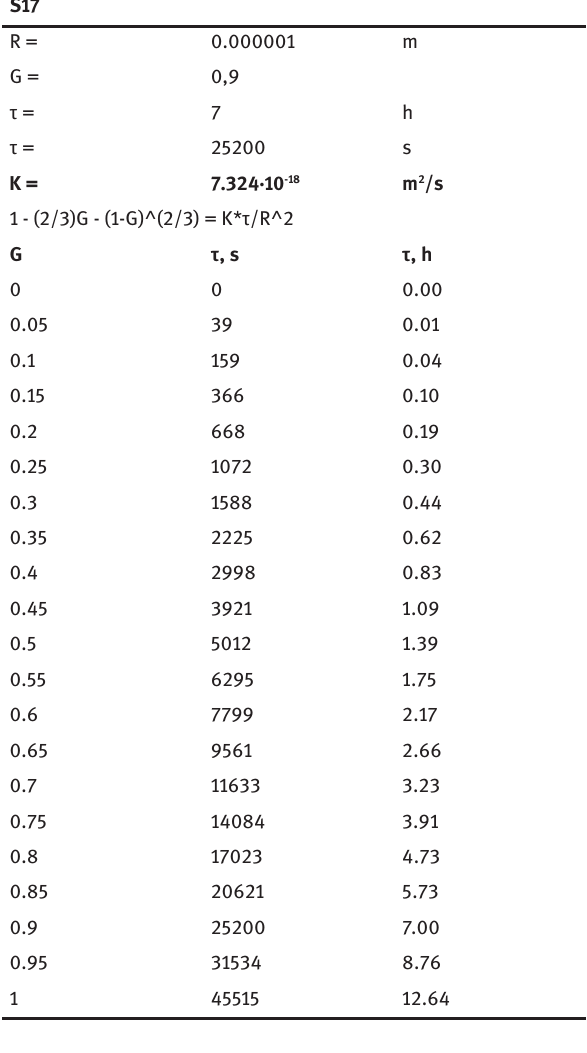
Table 1: Example of the numerical simulation output.